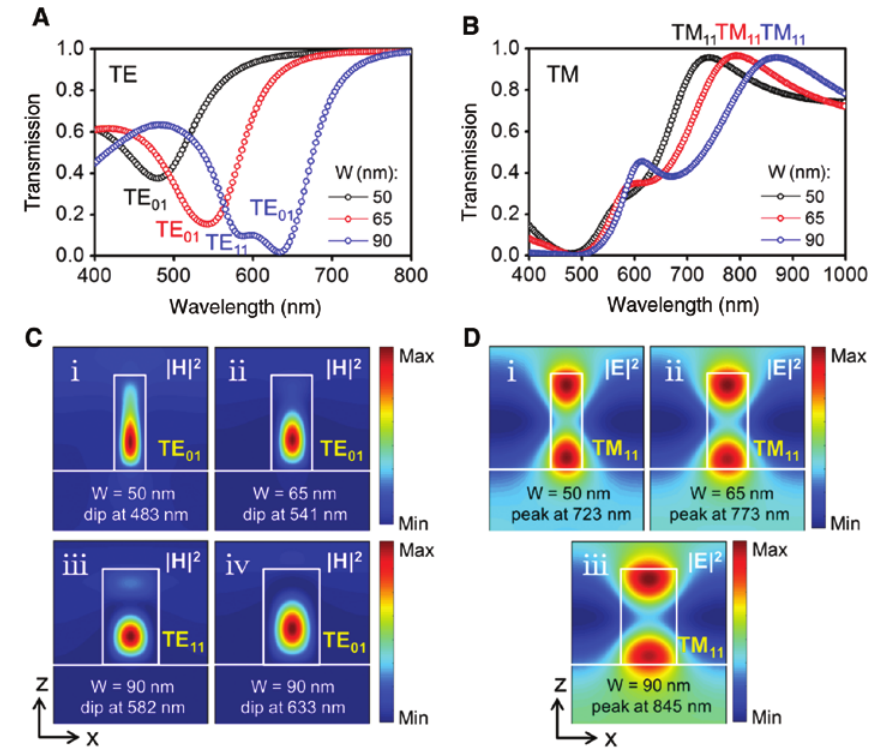
Figure 3: Resonance modes excited by the proposed color pixels. The simulated transmission spectra of the pixels with widths of 50, 65 and 90 nm under the (A) TE and (B) TM polarized illuminations. Intensity profiles of (C) H- and (D) E-field (|H| 2 , |E| 2 ) at the resonant wavelengths under the TE and TM polarized